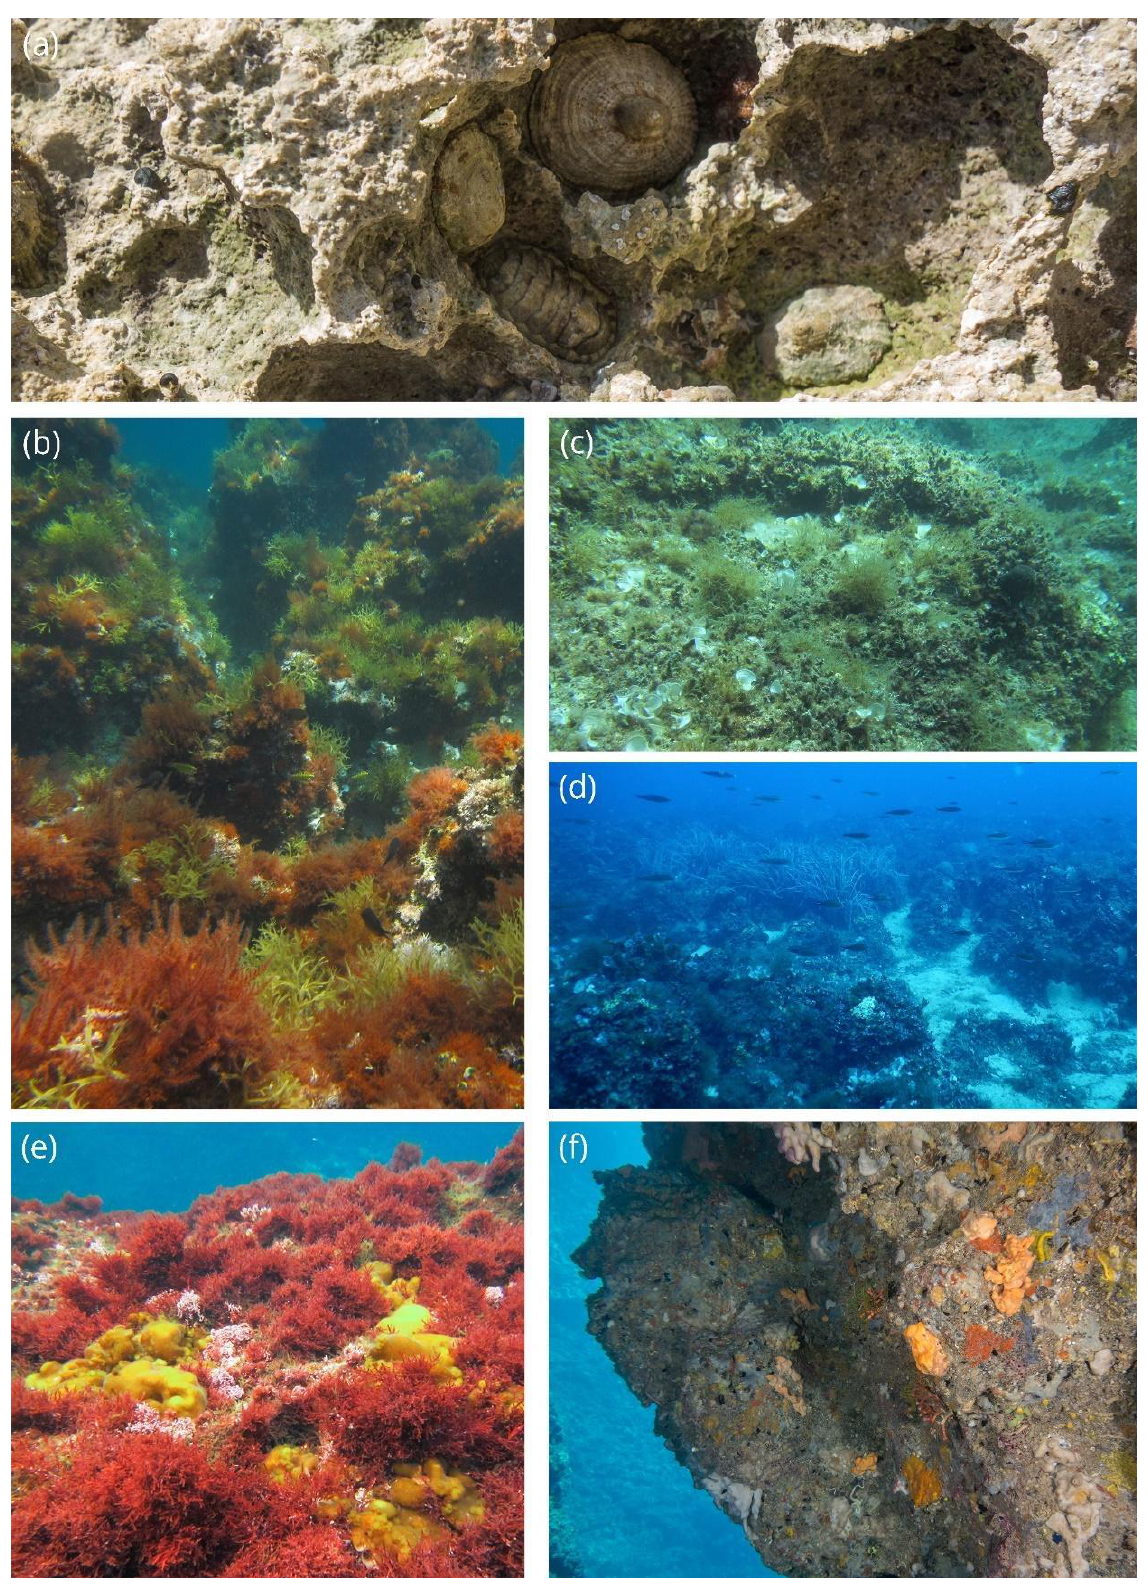
Figure 2. Marine habitats found in the coastal area of Tricase. ( a ) Intertidal zone, ( b ) upper infralittoral (2–4 m), ( c ) lower infralittoral (10–13 m), ( d ) coralligenous formation with Posidonia oceanica patches (17–22 m), ( e ) eutrophic infralittoral, ( f ) cave environment.